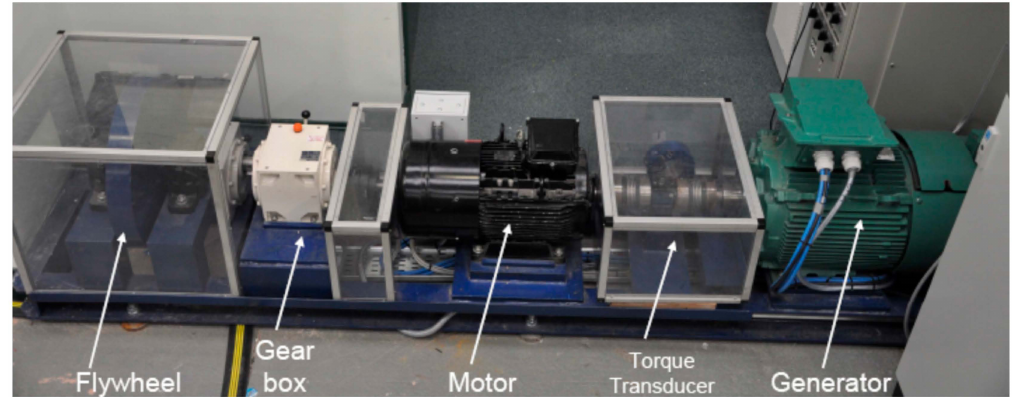
Figure 4. Drive train elements of the medium speed rotary emulator at the Lir NOTF laboratory.